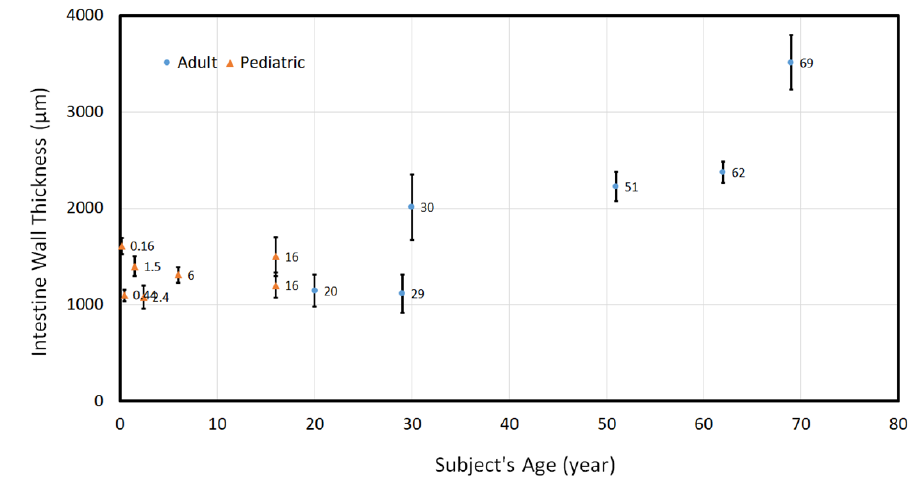
Figure 3. Geometrical metrics measurement of small intestine of a wide range of human subjects. Total number of human subjects was n = 61 for the full age range.